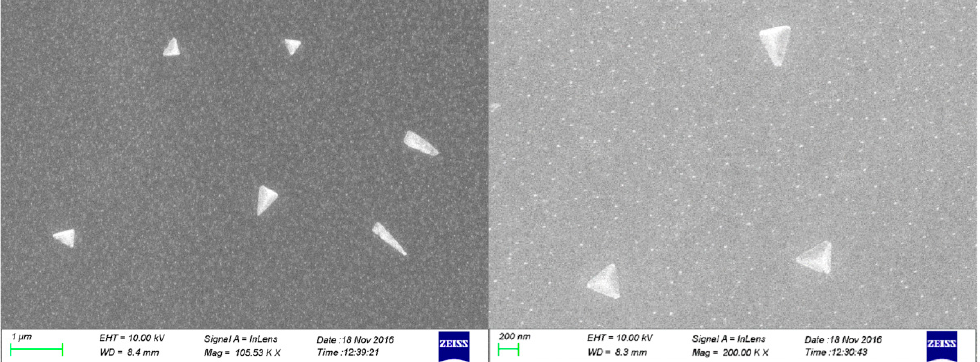
Figure 4. SEM images of prodigiosins nanoparticles produced by microbial fermentation.